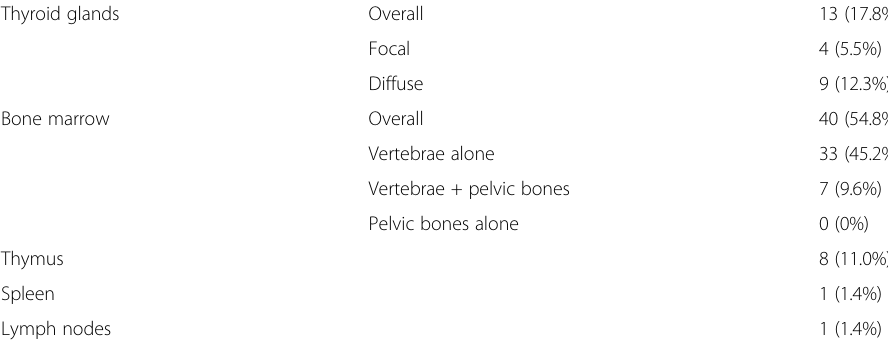
Table 3 Extra-vessel FDG uptake on 18 F FDG PET/CT scans ( n = 73) Thyroid glands Overall 13 (17.8%) Focal 4 (5.5%) Diffuse 9 (12.3%) Bone marrow Overall 40 (54.8%) Vertebrae alone 33 (45.2%) Vertebrae + pelvic bones 7 (9.6%) Pelvic bones alone 0 (0%) Thymus 8 (11.0%) Spleen 1 (1.4%) Lymph nodes 1